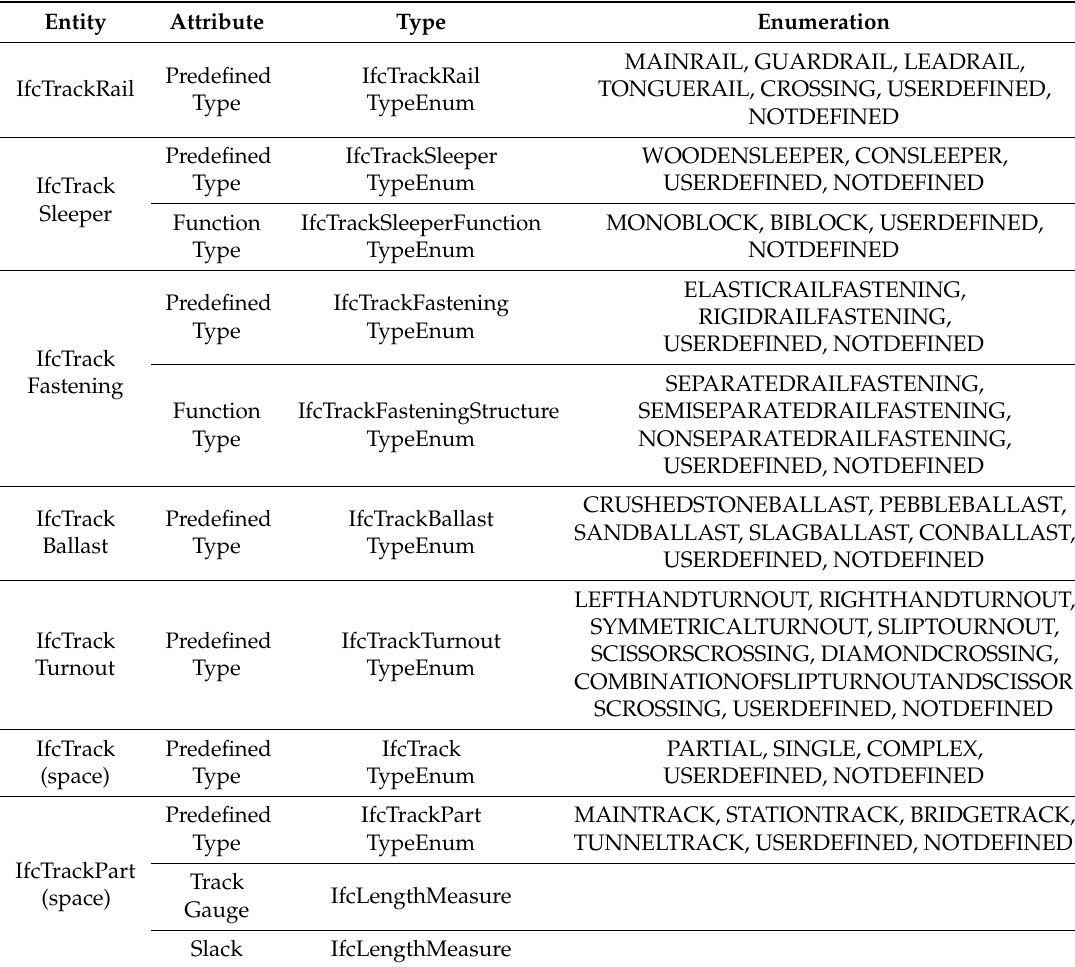
Table 1. Attributes and types of extended physical